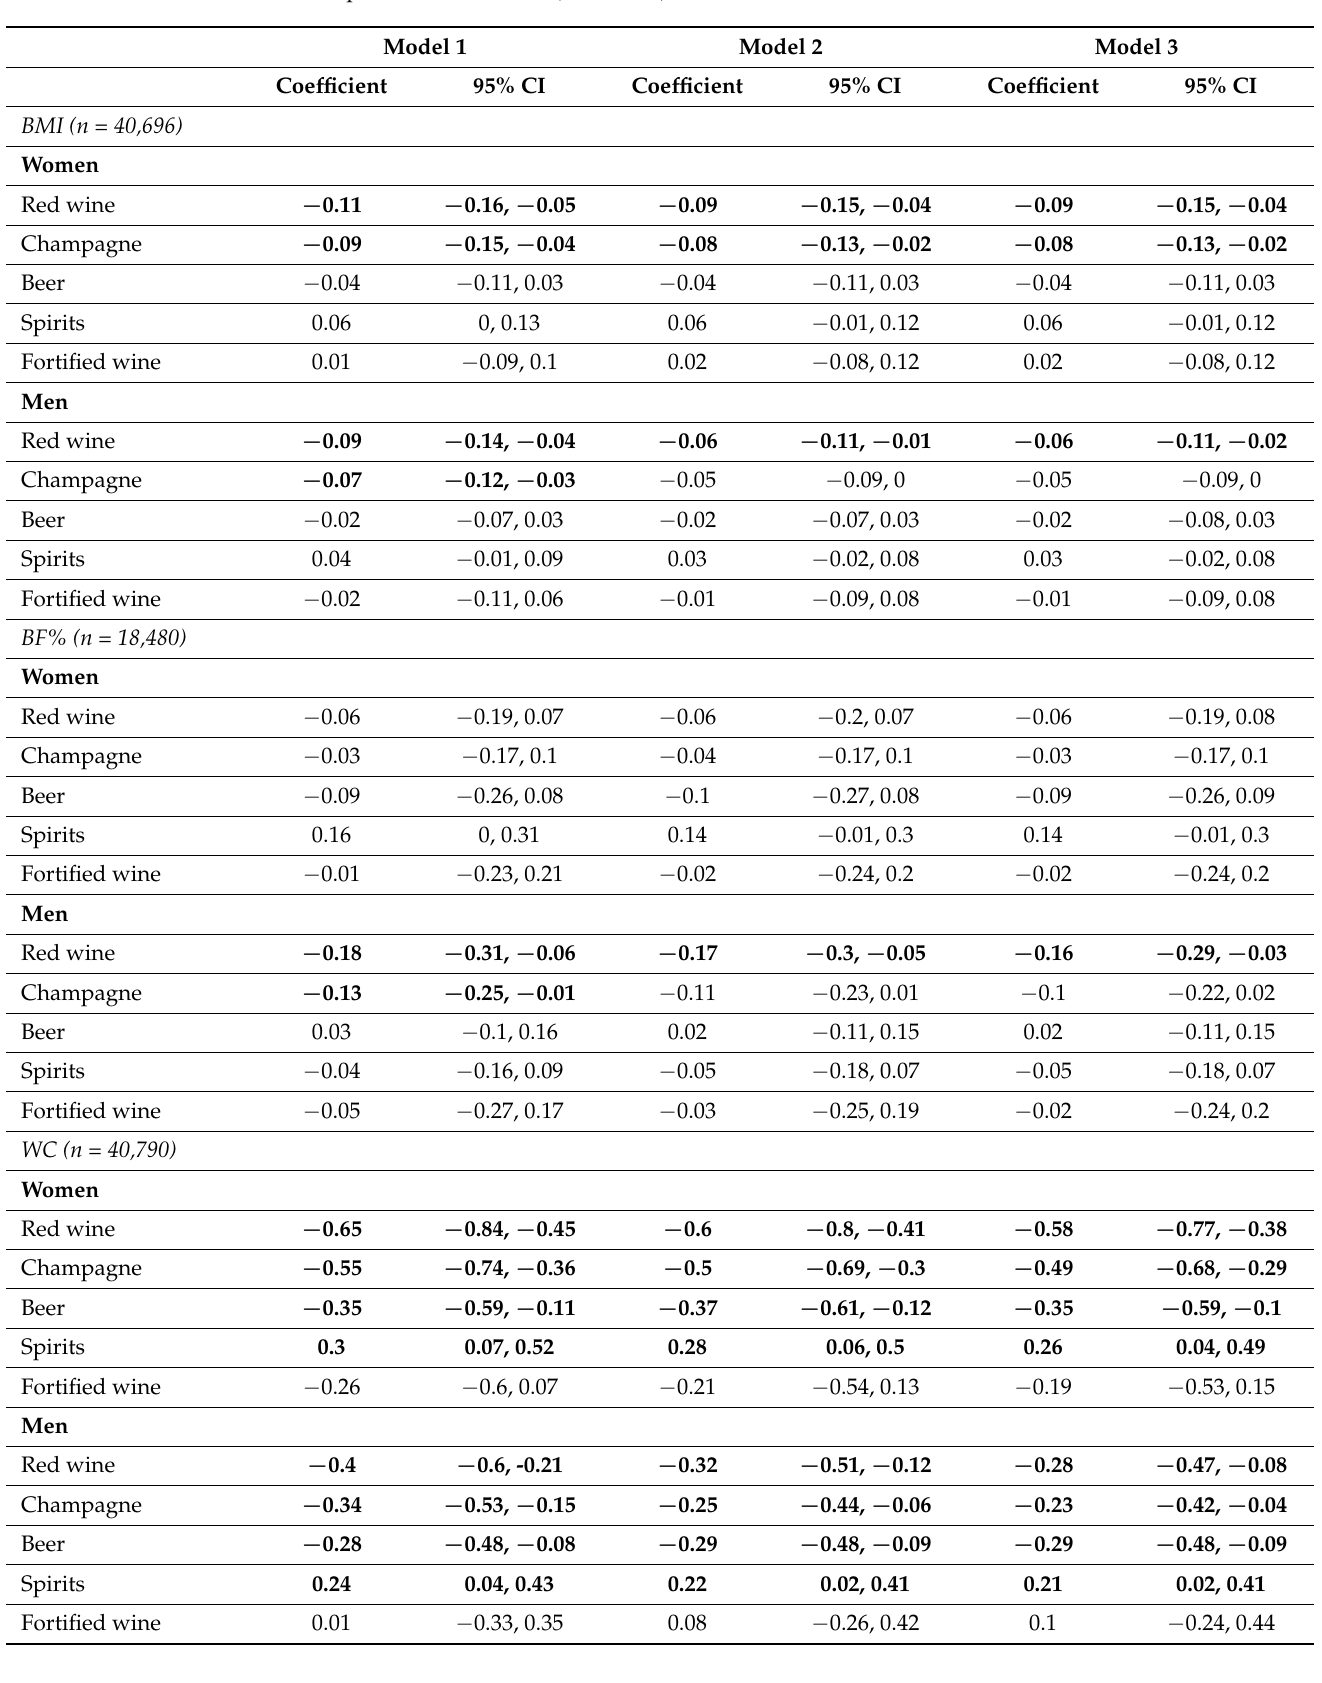
Table 3. Longitudinal associations between type-specific alcohol consumption and adiposity at follow up in the UK Biobank ( n =